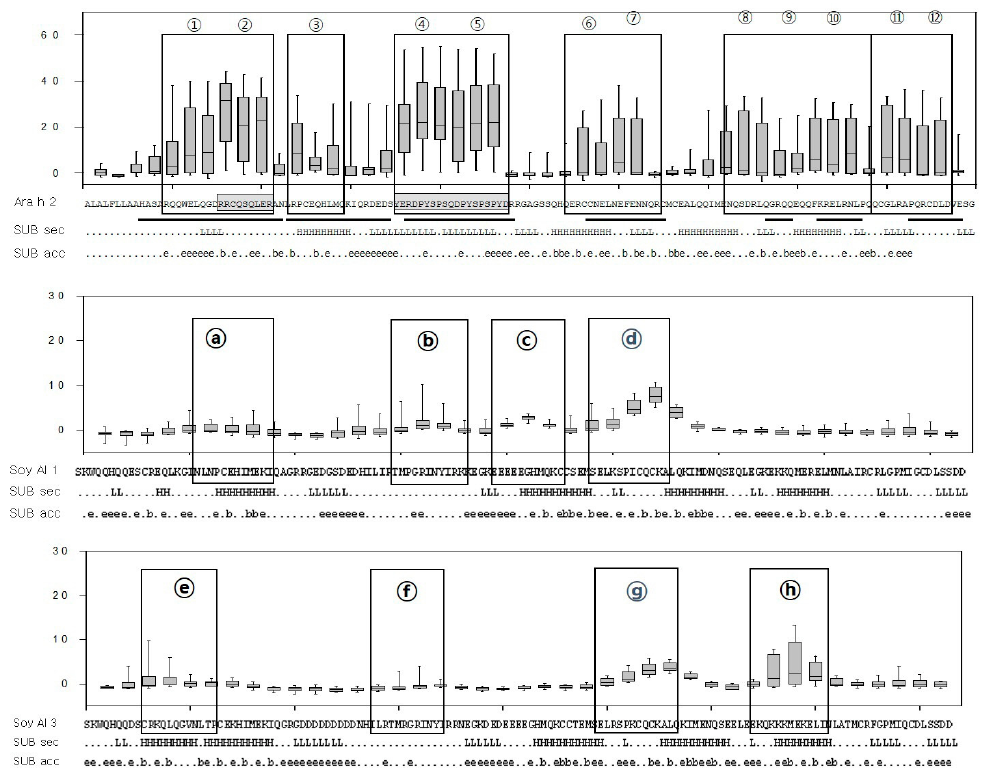
Figure 3. Box-and-whisker plots of the peptides and predicted secondary structure and solvent accessibility. The X -axis represents each peptide and the Y -axis represents the signal intensity ( Z score). The median, first, and third quartiles of the Z score are shown and vertical lines extend between the 5th and 95th percentile. Sequences of Ara h 2, Soy Al 1, Soy Al 3, and epitopes are shown under each graph. The black boxes represent epitopes identified in the present study and underlines represent those previously defined. Subset of predicted secondary structure (SUB sec) shows the predicted secondary structure of the proteins, where H and L represent helical and loop structures, respectively. Subset of predicted solvent accessibility (SUB acc) shows the likelihood of relative solvent accessibility for proteins, b = 0%–16%, e = 16%–100%.